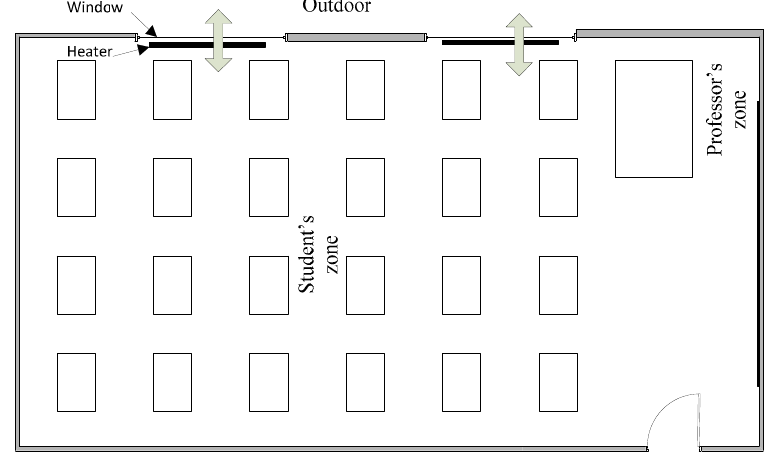
Figure 1. Typical school building plant.